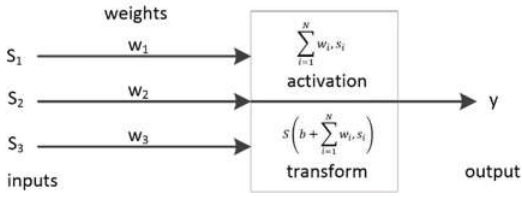
Figure 2. Neurons output calculation.